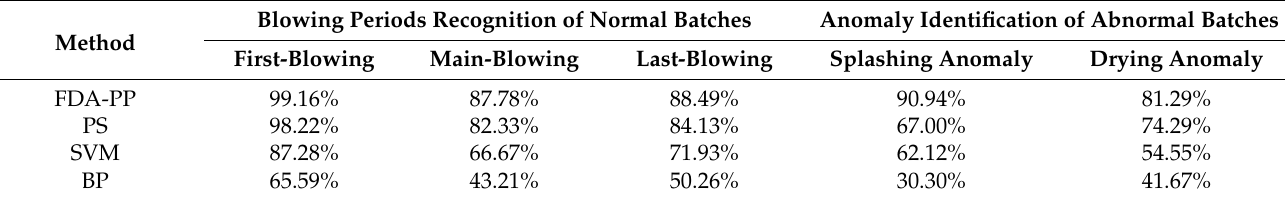
Table 2. Accuracy of production state